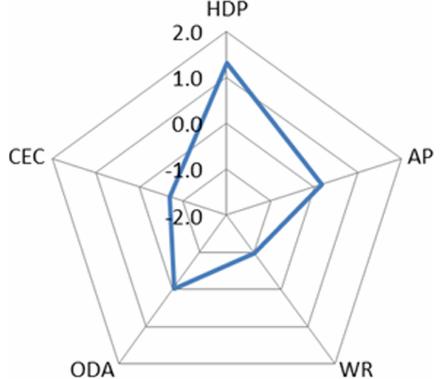
Fig. 6. Profile 2 – besides good human development (HDP), this profile presents very low values in terms of level of accountabil- ity/democracy, together with low interest in environmental matters (CEC). The relatively wealthy situation allows stepping over the scarce water resources context (WR) by showing a high level of WSS services.